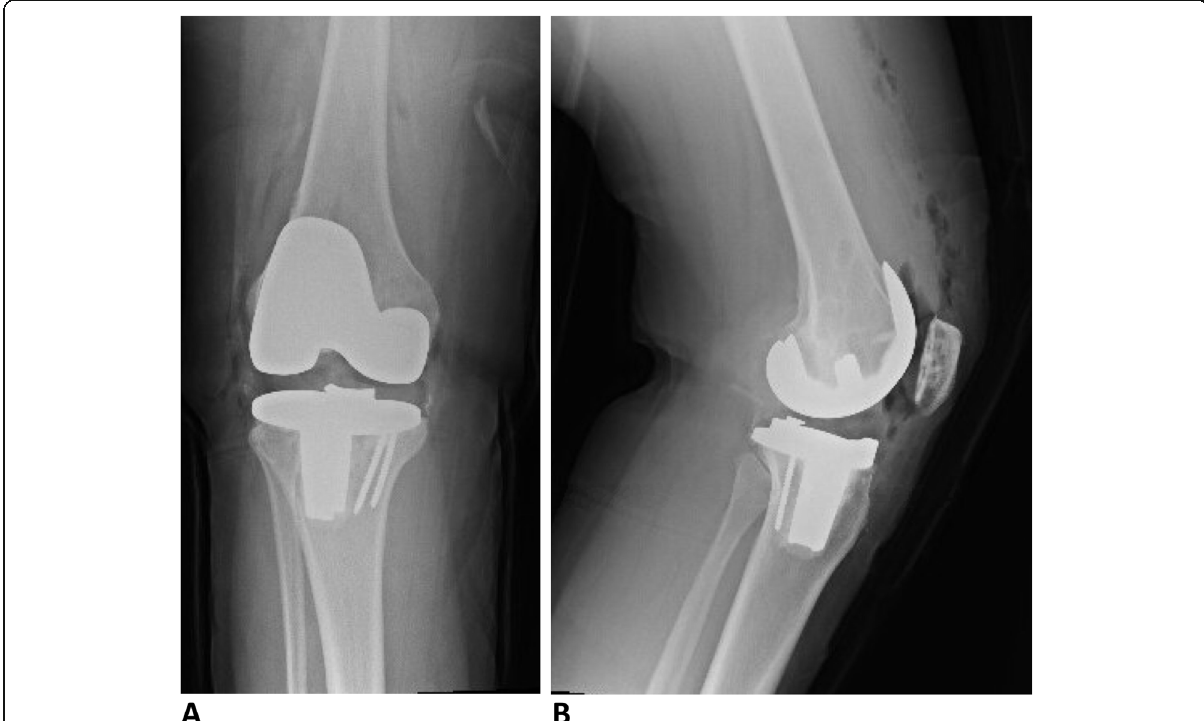
Fig. 5 Postoperative radiographs demonstrating appropriate alignment and position of total knee arthroplasty implants on ( a ) AP view and ( b ) lateral